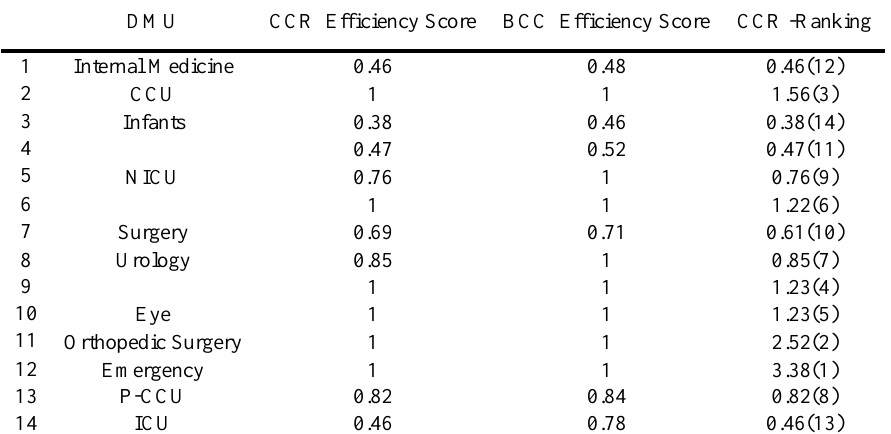
Table 3. Efficiency score and ranking in case study application in year 1389. DMU